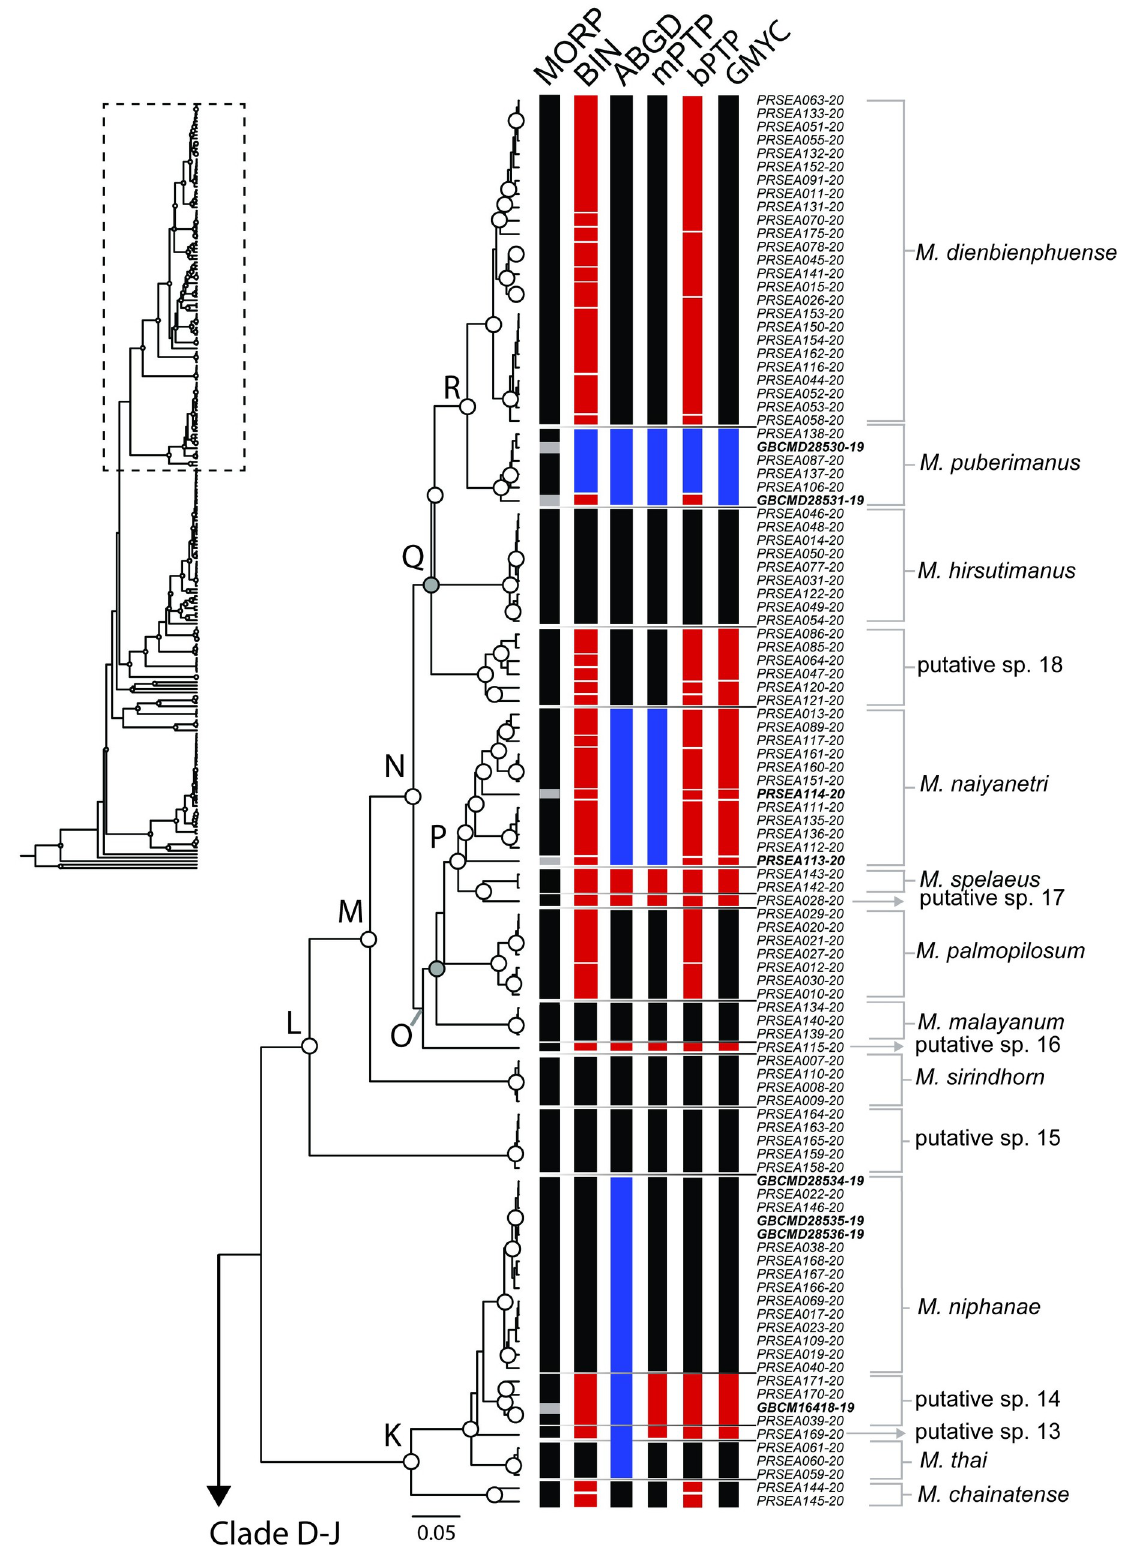
Fig 5. Ultrametric tree of Indochinese Macrobrachium indicating clade support level and species delimitation clustering results (part 3). For abbreviations used on tree see Fig 3. https://doi.org/10.1371/journal.pone.0252546.g005 PLOS ONE | https://doi.org/10.1371/journal.pone.0252546 June 2,